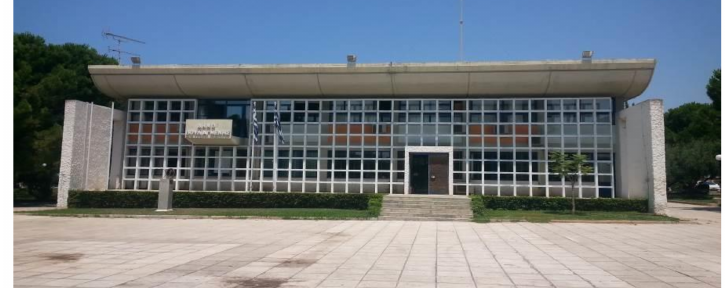
Figure 2. City Hall of Voula [source: InnoWEE project]. The existing HVAC system consists of split air conditioning units of different